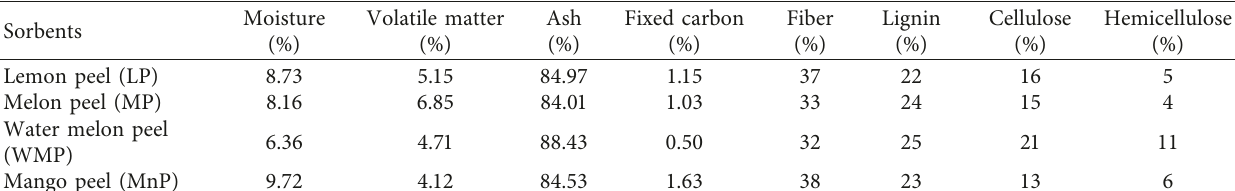
Table 1: Physicochemical analysis of sorbent materials.